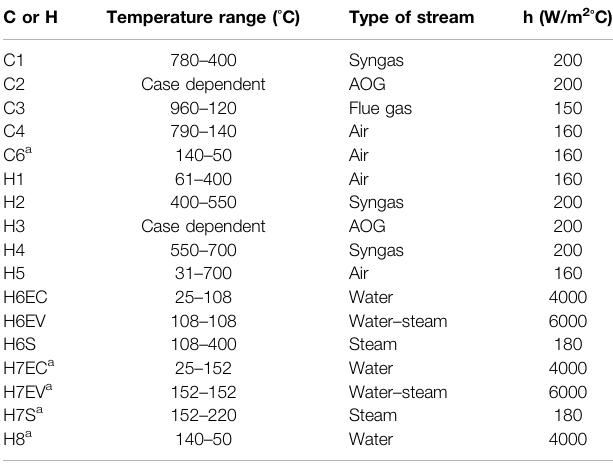
TABLE 4 | List of the heating and cooling needs of the Bio-SOFC plant (H: heater, C: cooler), their fi xed temperature, type of stream, and estimated fi lm transfer coef fi cient (h, in W/m 2 ° C) (Smith, 2005; Towler and Sinnott, 2013). In order to calculate the exchange area linked to the cold utility, h (cid:1) 6000 W/m 2 ° C was